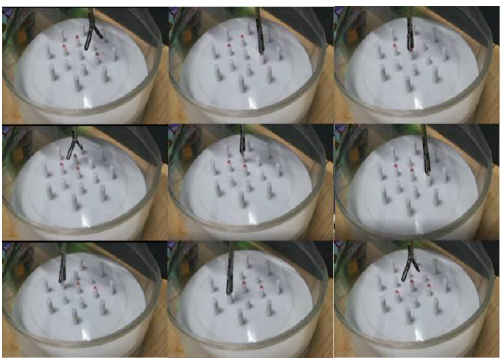
Figure 15. The experimental process of gripping and handling.